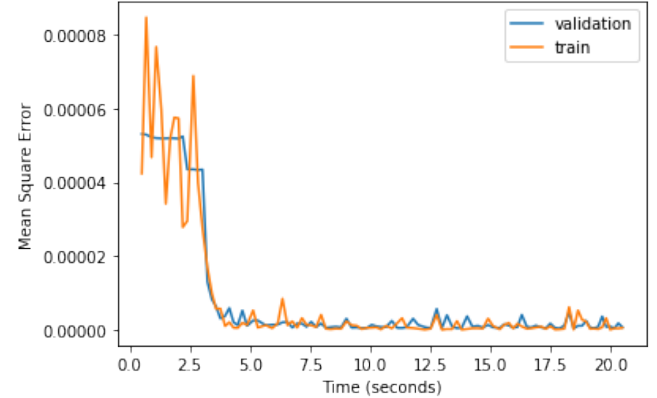
Figure 6. MSE convergence for training and validation data in the DNN (single